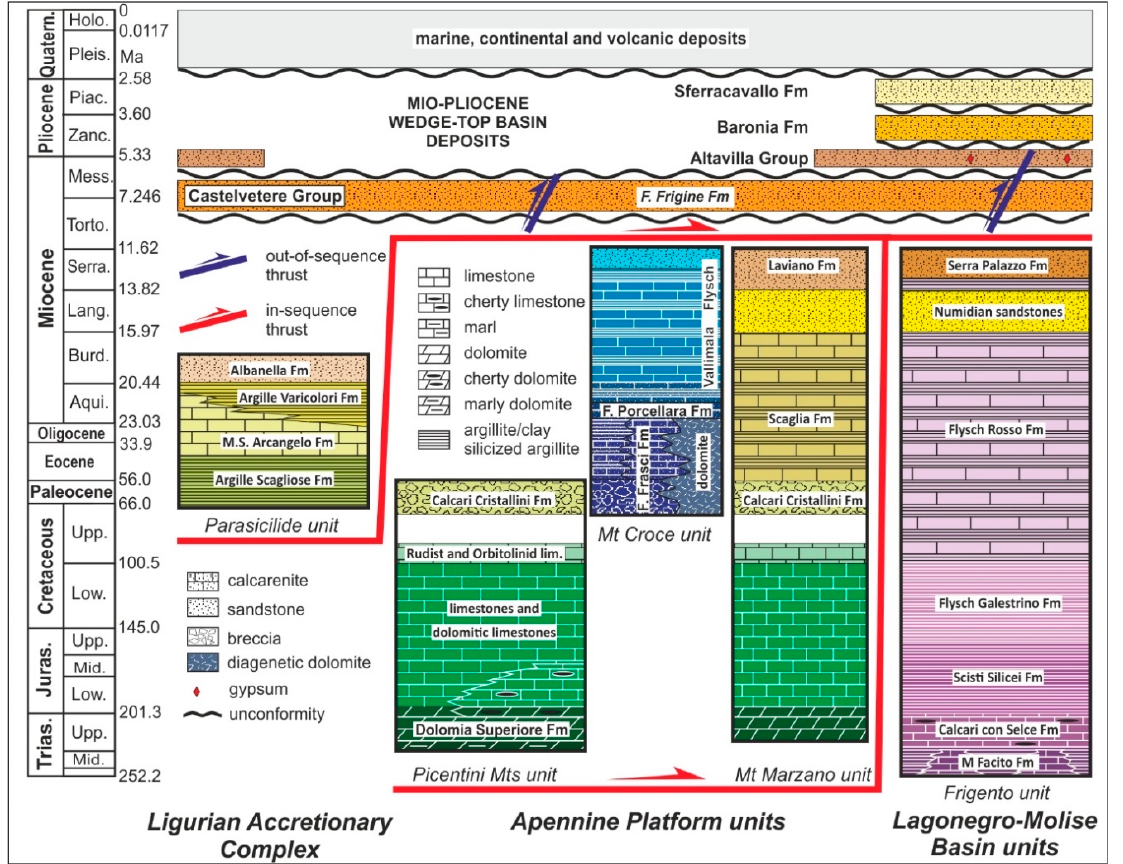
Figure 2. Schematic stratigraphic logs of the successions exposed in the Giffoni and Campagna tectonic windows (modified after [11]).